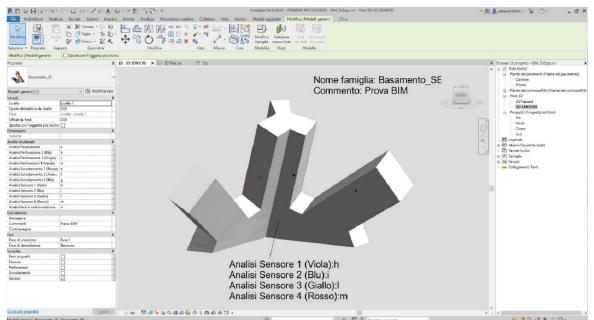
Figure 17 . South-eastern basement of the pillars of the pavilion C, modelled in the Rhinoceros platform and implemented in a BIM environment (the adopted platform is Autodesk